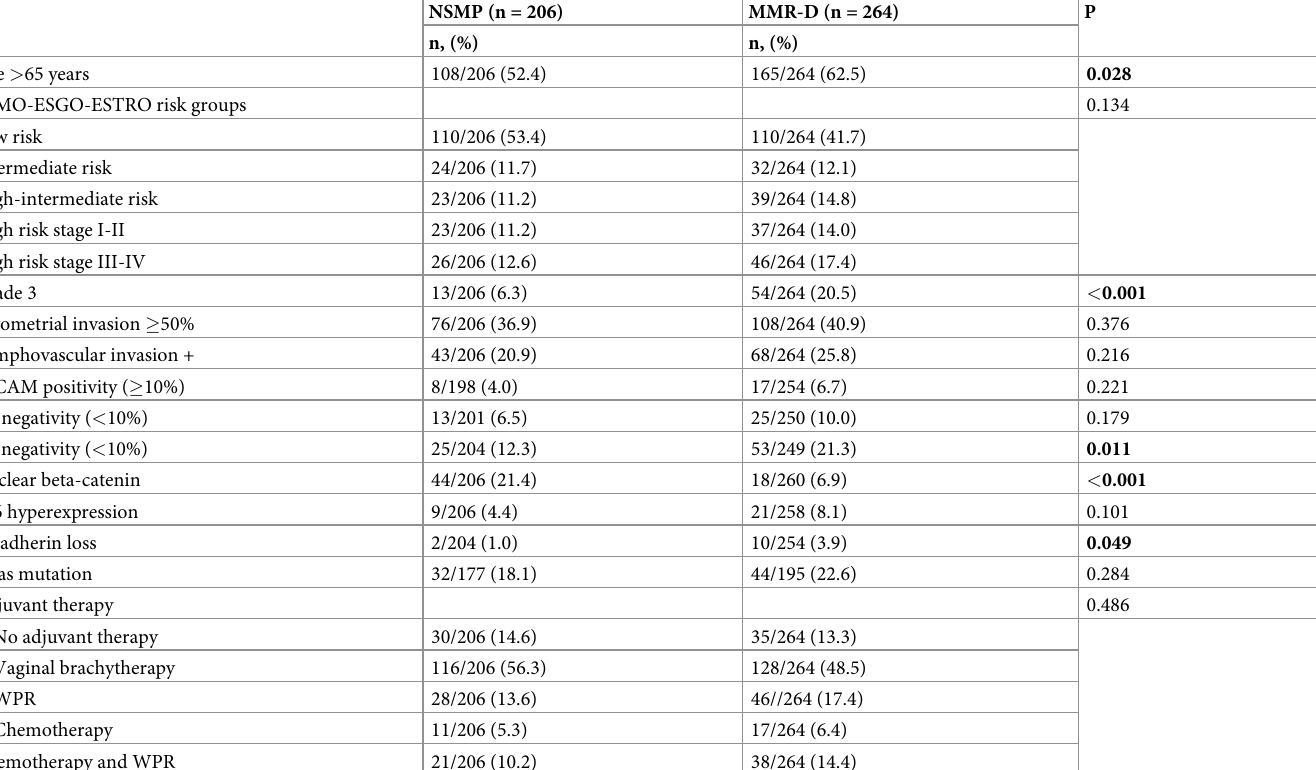
Table 1. Clinicopathologic characteristics and molecular features according to the molecular subgroup in stage I-IV endometrioid endometrial carcinoma (n =